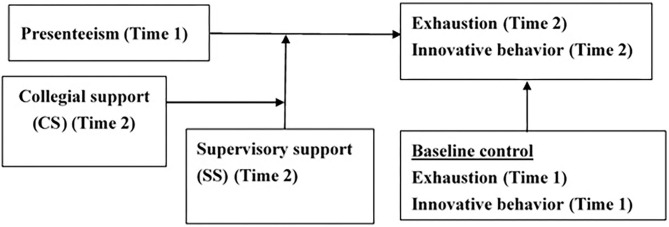
The research model.